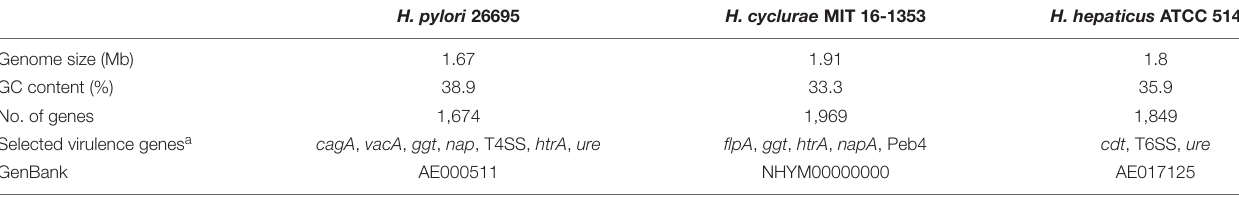
TABLE 2 | Profile of the H. cyclurae draft genome compared with H. pylori and H. hepaticus